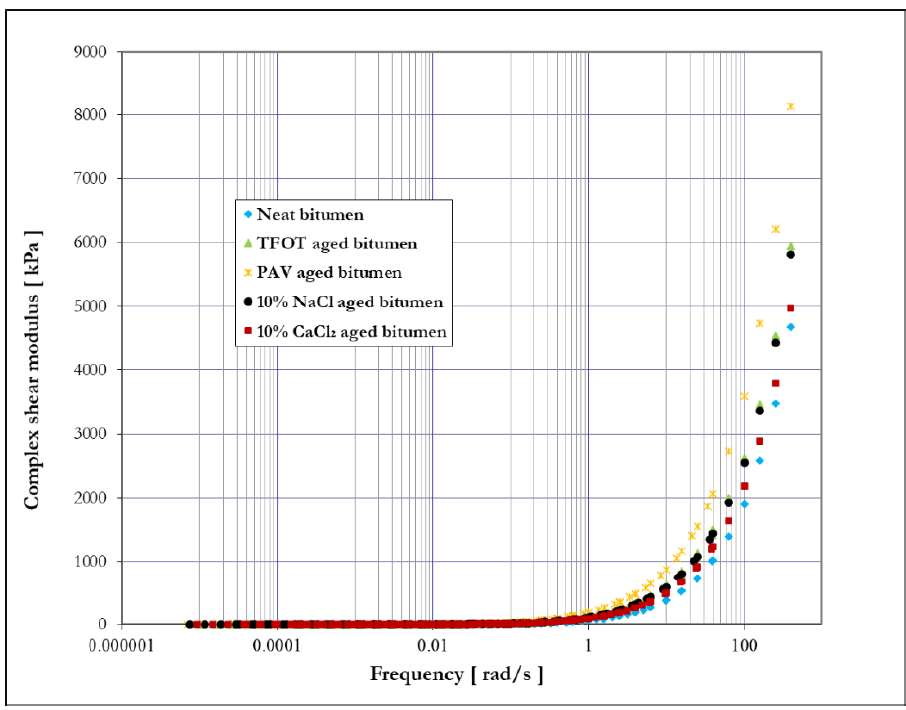
Figure 8. Master curve—complex shear modulus versus loading frequency.